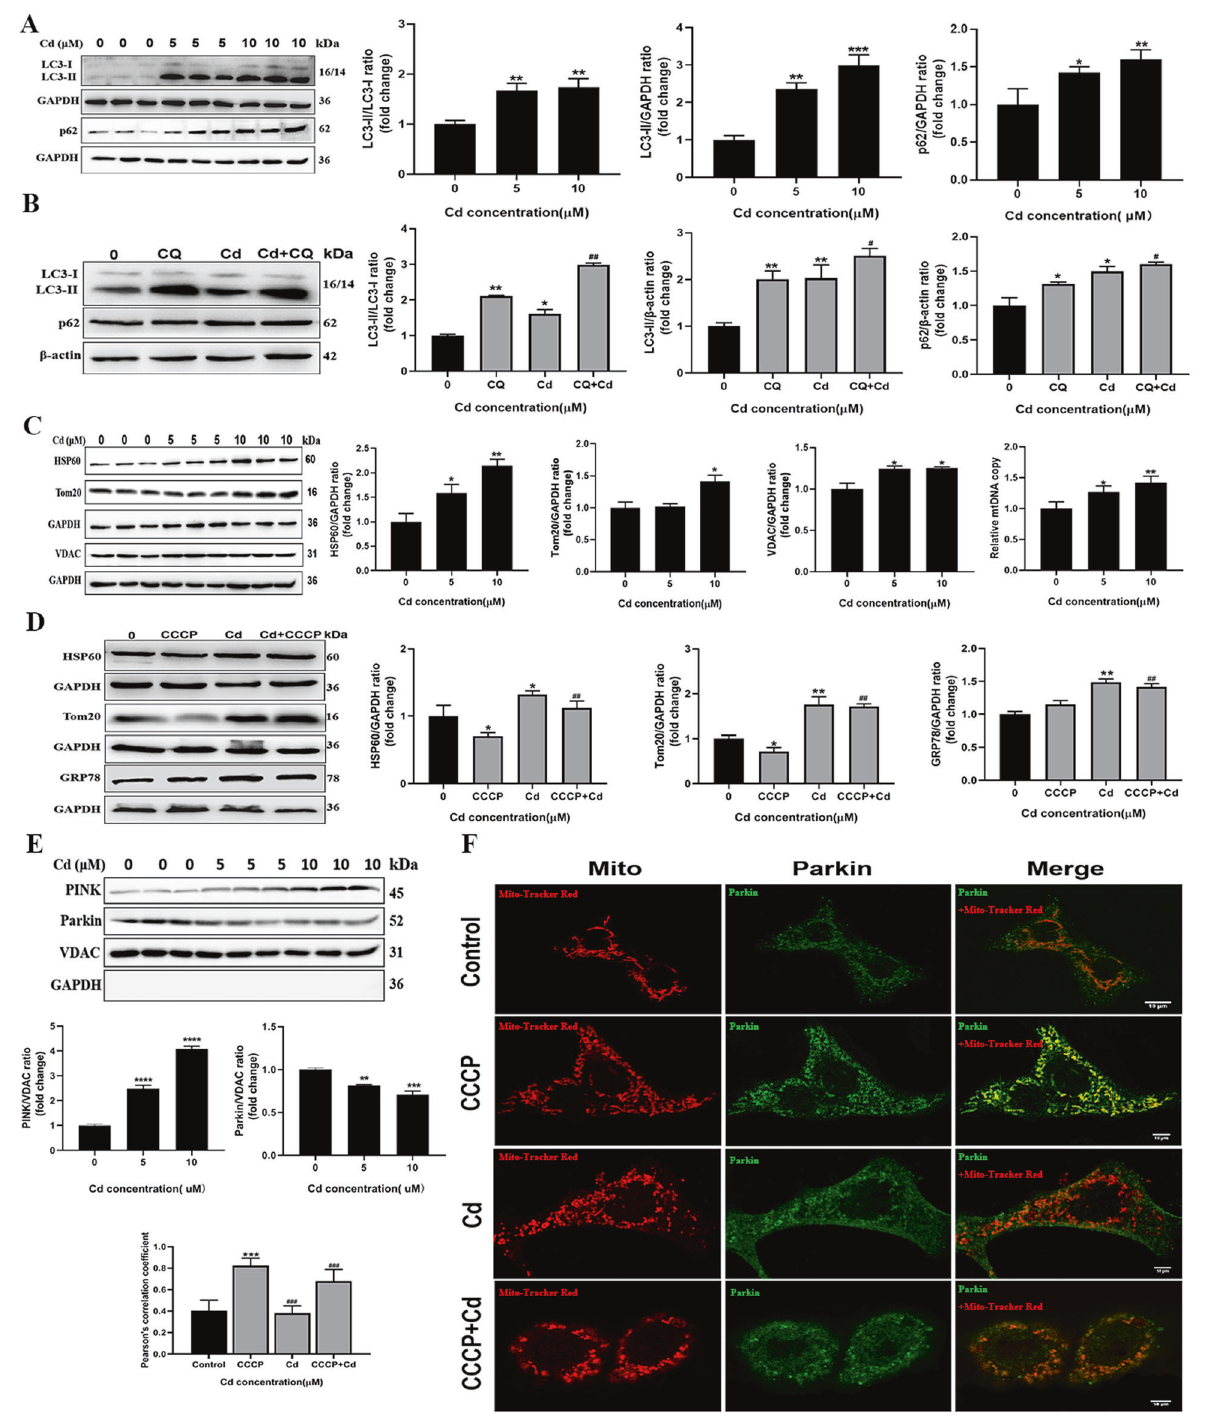
Fig. 8 Cadmium-induced mitochondrial fragmentation was associated with inhibition of mitophagy. A Expression levels of mitophagy markers LC3 and p62 were examined by Western blot after TM3 cells were treated with cadmium. B The cells were treated with or without chloroquine (CQ, 10 μ M) in the presence or absence of cadmium for 24 h. The expression of LC3 and p62 was measured. C The effect of cadmium on mitochondrial mass was analyzed by immunoblotting for mitochondrial proteins (HSP60, TOM20 and VDAC) and measuring mitochondrial DNA (mtDNA) copy number. D The cells were exposed to 10 μ M cadmium for 24 h with or without pretreatment with 10 μ M CCCP for 2 h. The levels of mitochondrial proteins (HSP60 and Tom20) and an ER protein GRP78 were measured. E Mitochondria were isolated from the cadmium-treated cells and the expression of PINK and Parkin were measured by Western blot. VDAC and GAPDH were used as internal references for the mitochondria and cytosol, respectively ( F ) The cells were treated with cadmium and CCCP as above and then stained with mitochondrial probes (Mito-Tracker Red CMXRos) and anti-Parkin antibodies (Green). The colocalization between mitochondria and Parkin was analyzed by immuno fl uorescence. Data represent the mean±SD for at least three independent experiments (* P < 0.05, ** P < 0.01, *** P < 0.001, **** P < 0.0001 vs. control; ## P < 0.01, ### P < 0.001, vs. CQ or CCCP).